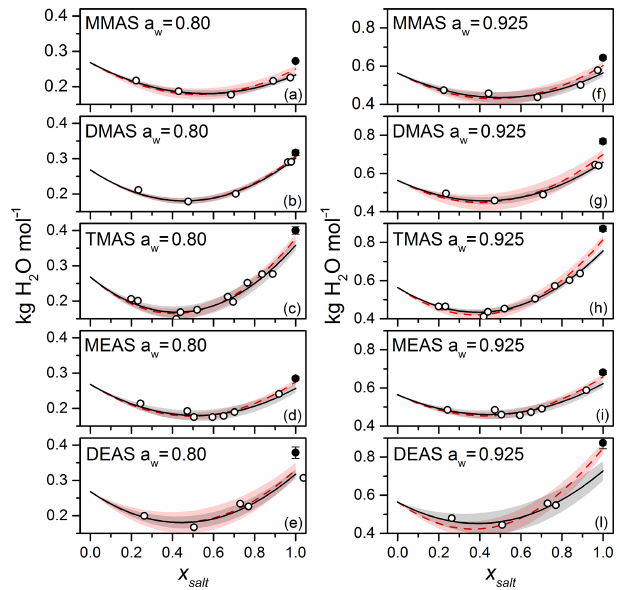
Figure 7. Mass of H 2 O (kg) per mole of solute as a function of the degree of neutralisation of sulfuric acid by amine ( x salt ) . Symbols: solid circles – data from this work; open circles – data from Sauer- wein et al. (2015). Lines: black – ZSR fitting of the data in Sauer- wein et al. (2015); red dashed – same ZSR fitting but including the CK-EDB data point for each a w ; shaded envelopes – uncertainty associated with the